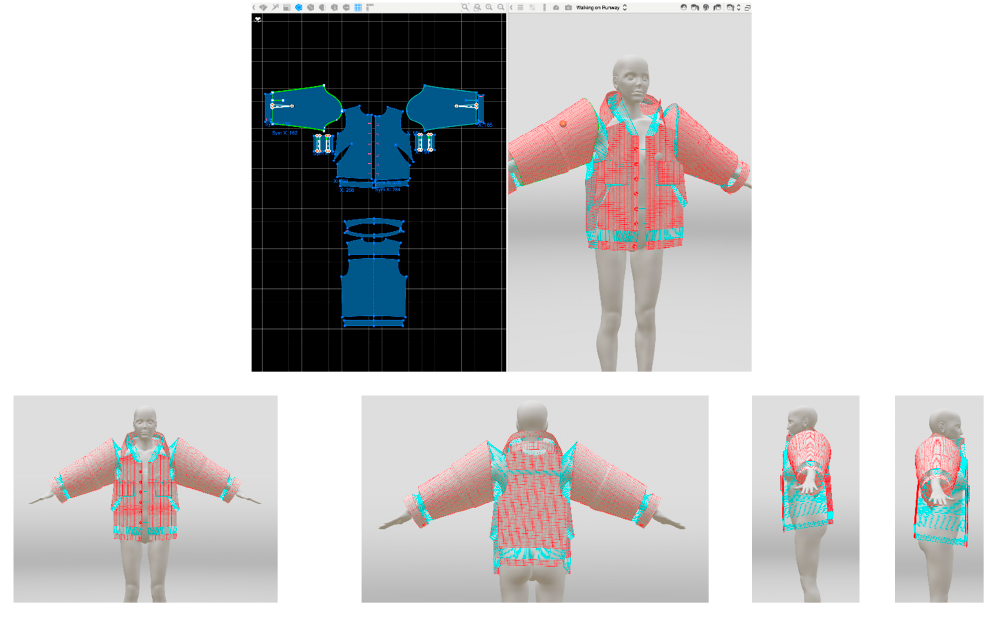
Figure 9. A denim-styled jacket with pockets positioned on the bust and metallic buttons as front fastening.